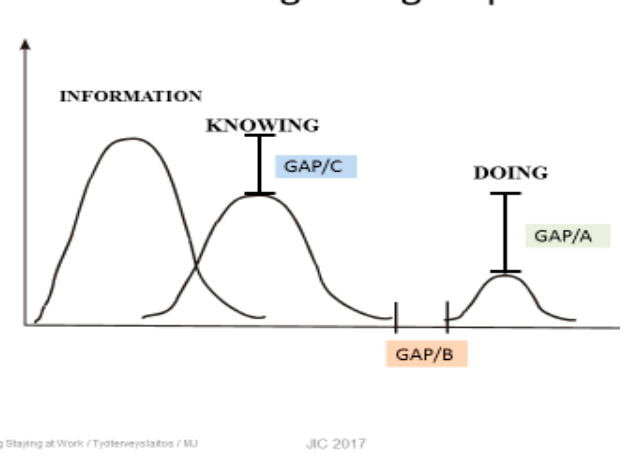
Figure 2. The knowing–doing gap model [14].